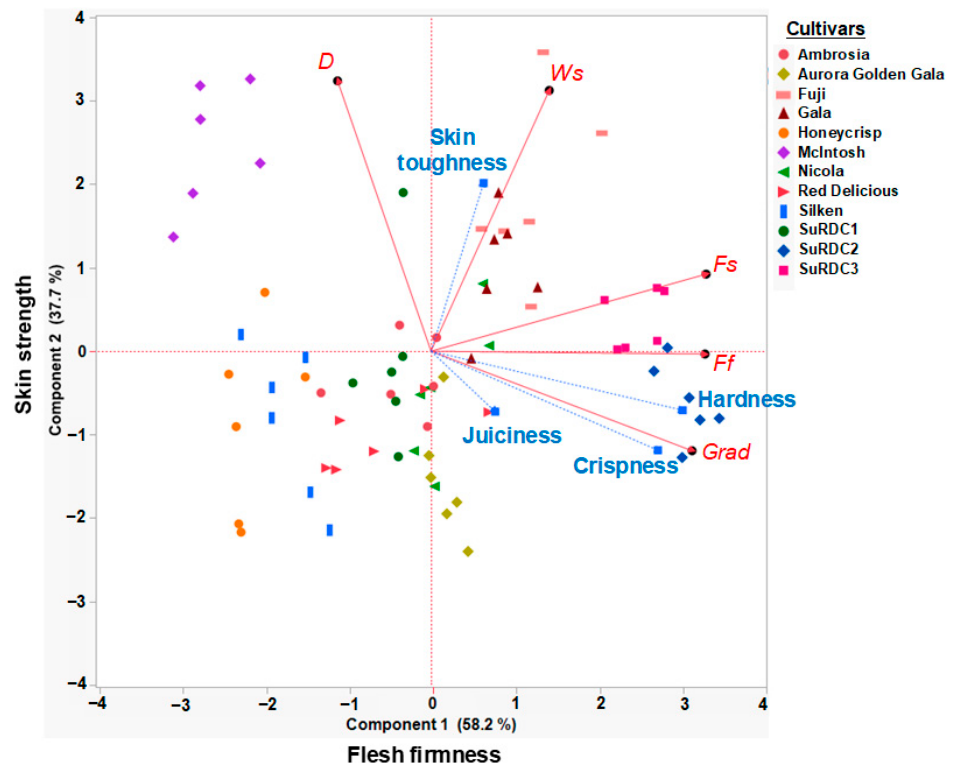
Figure 2. Principal component analysis biplot calculated using standardized mean values of five TA.XT plus Texture Analyzer parameters ( Fs , Ws , Grad , D , and Ff ). Instrumental measurements, as described in Table 1, are identified by red lines. Apple cultivars are identified with symbols of unique colors and shapes. Sensory textural attributes (crispness, hardness, juiciness, and skin toughness) are identified by blue lines, and positioned on this plot using correlation analysis (see Section 2.5).